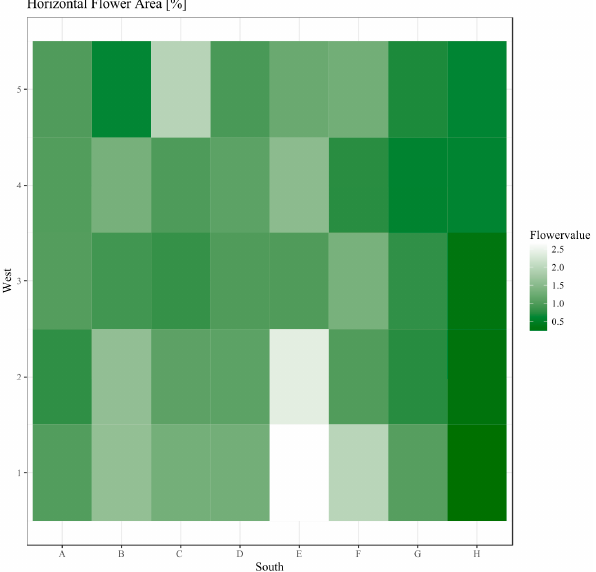
Figure 4. Horizontal flower surface in percent. Maximum is 3.0% (white) and minimum is 0.1% (dark green) for the analyzed fields in the 50 × 50 m 2 area by using threshold 140.